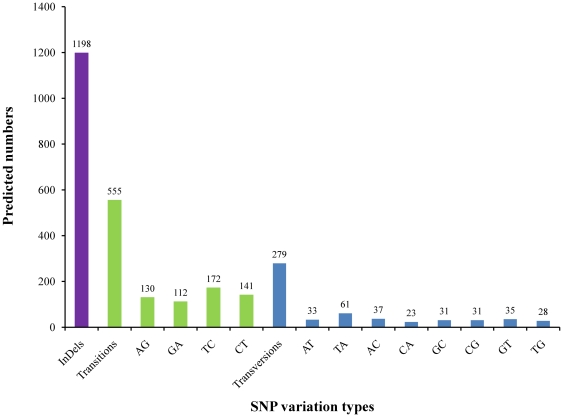
Distribution of putative single nucleotide polymorphisms (SNP) and indels in M. rosenbergii sequences.